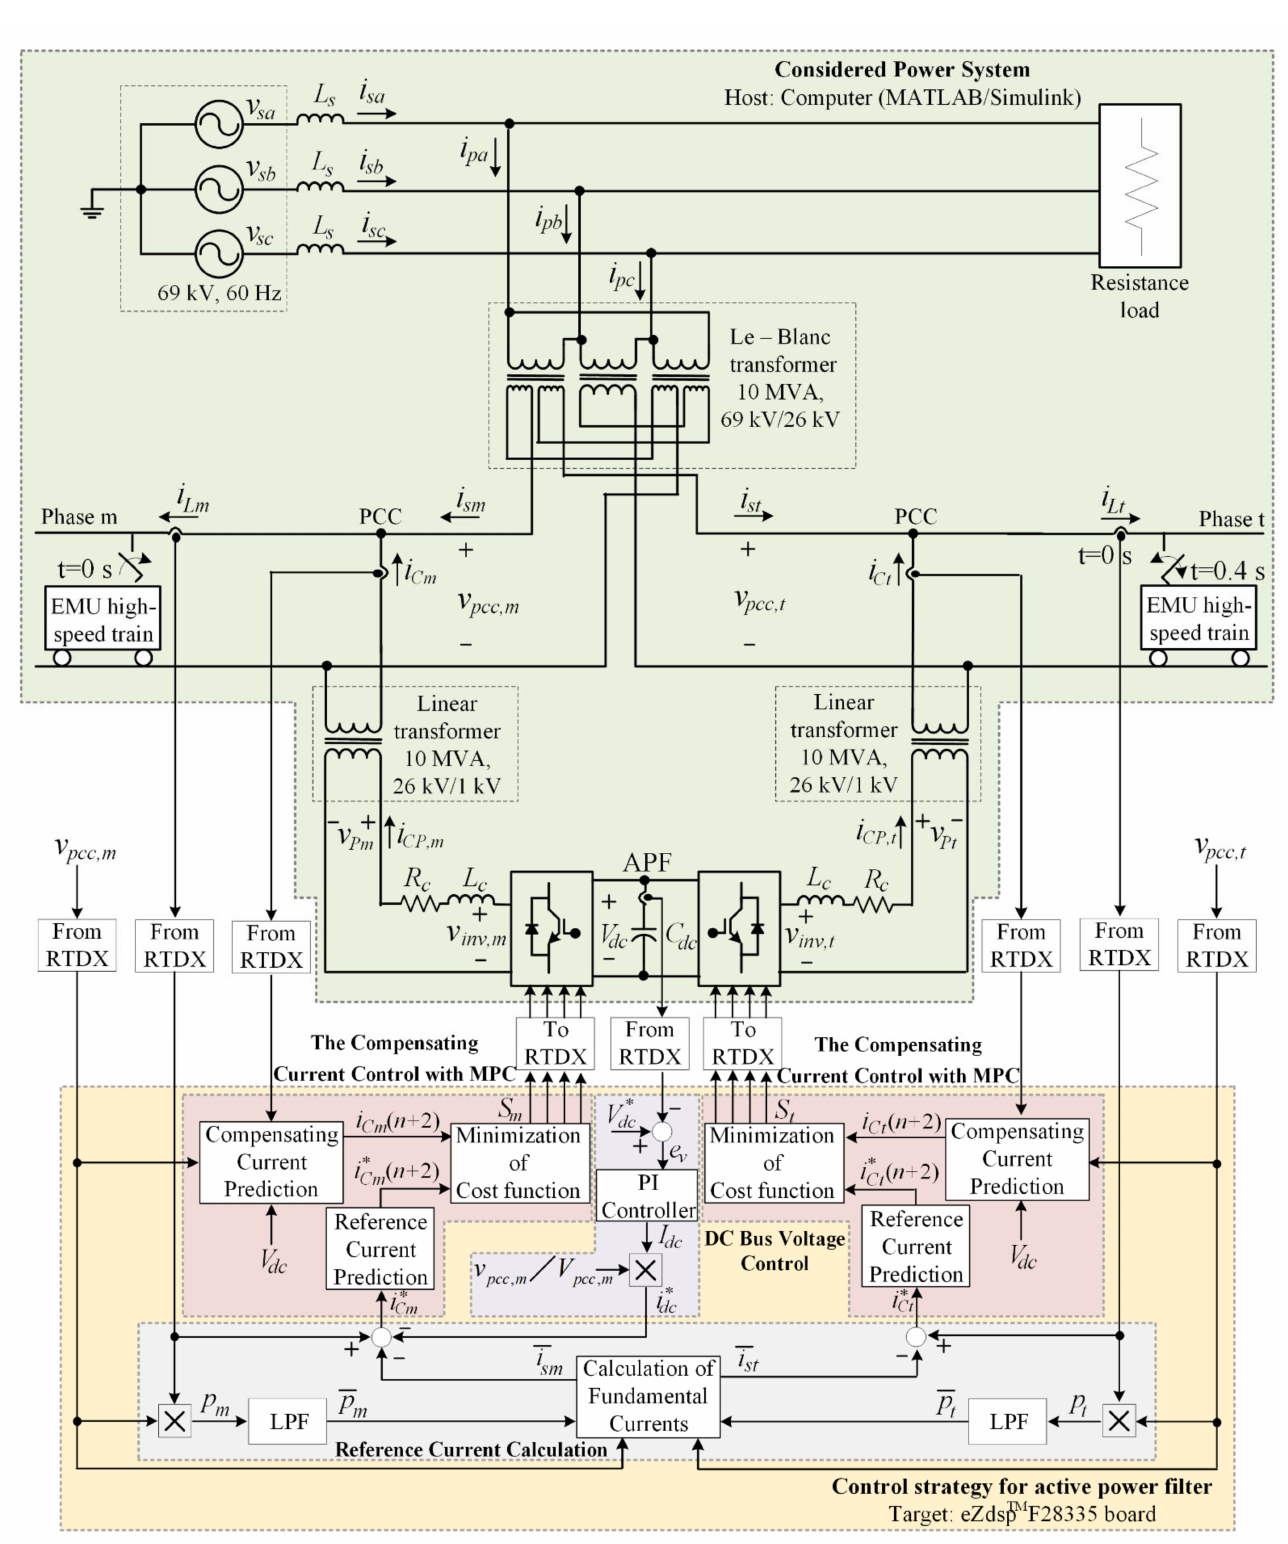
Figure 7. The HIL simulation model for the harmonic mitigation using the APF in the electric railway